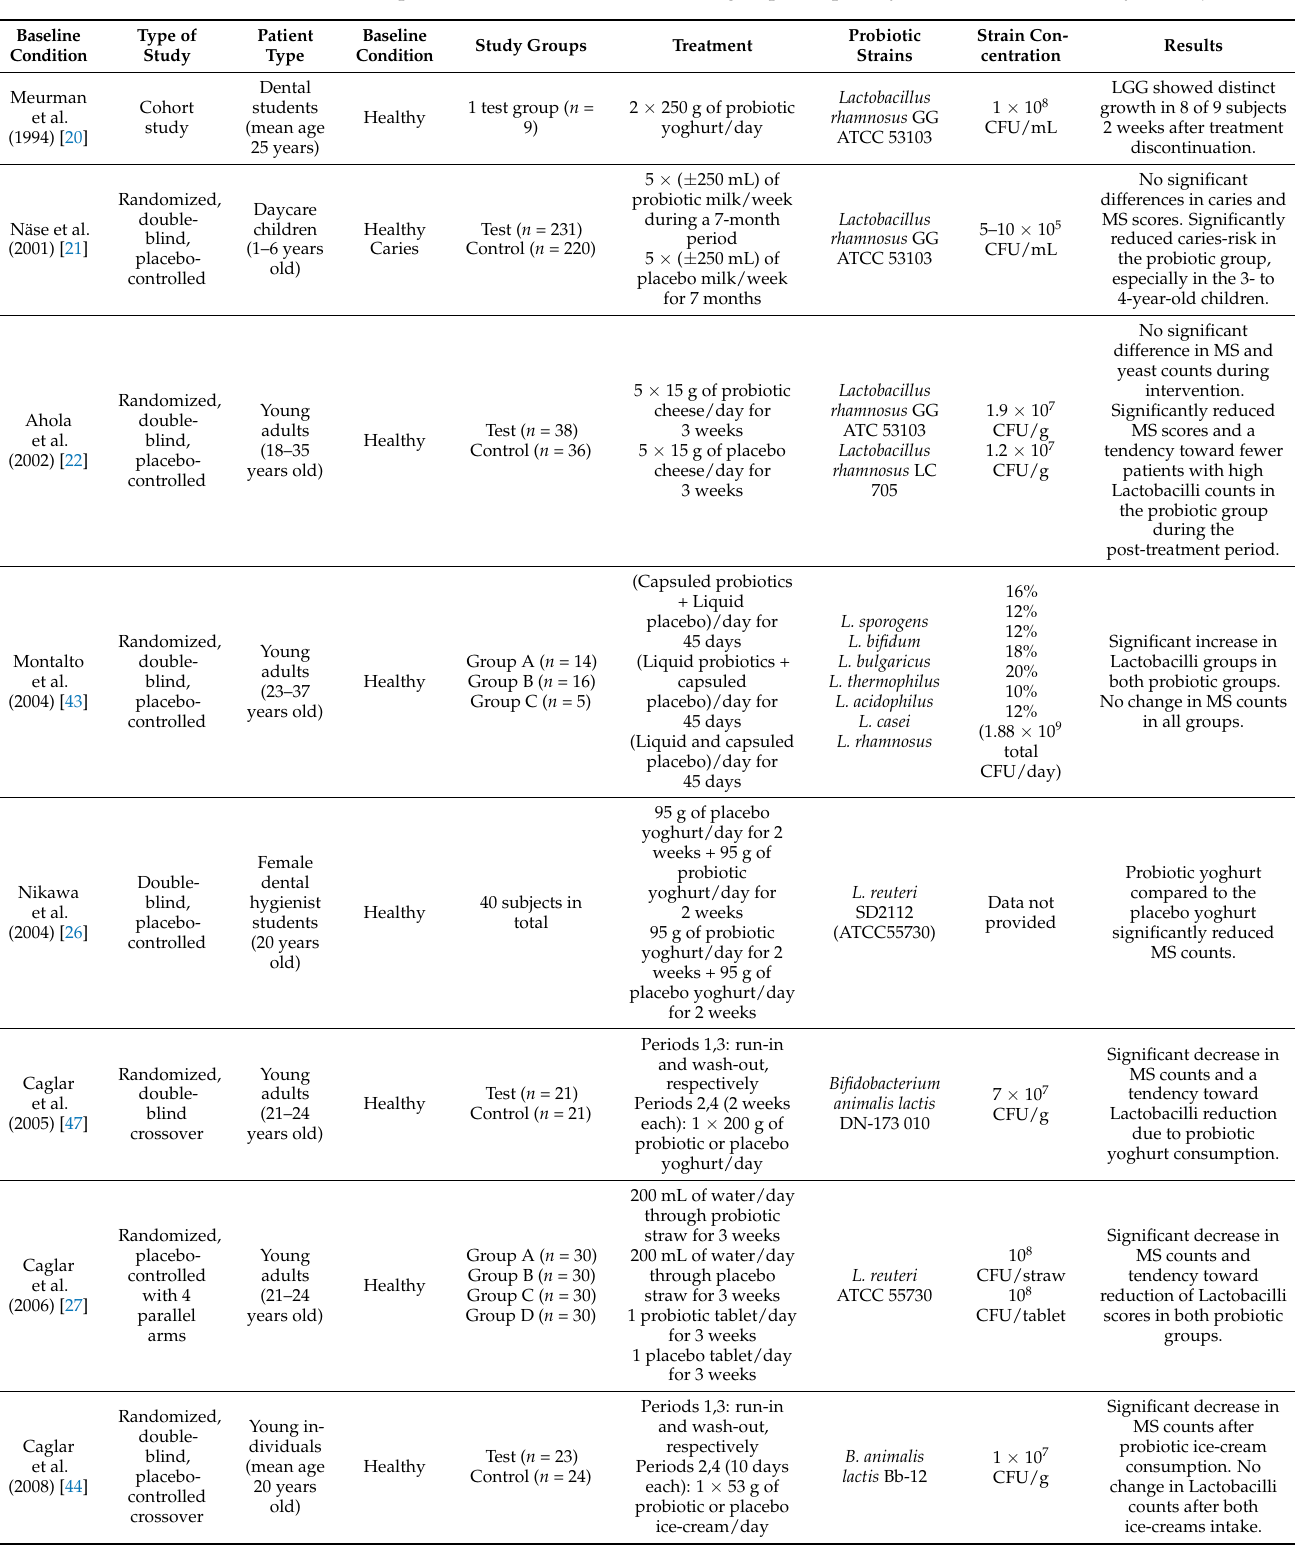
Table 2. Clinical trials around oral probiotics utilized without aiming to preemptively colonize the oral cavity of